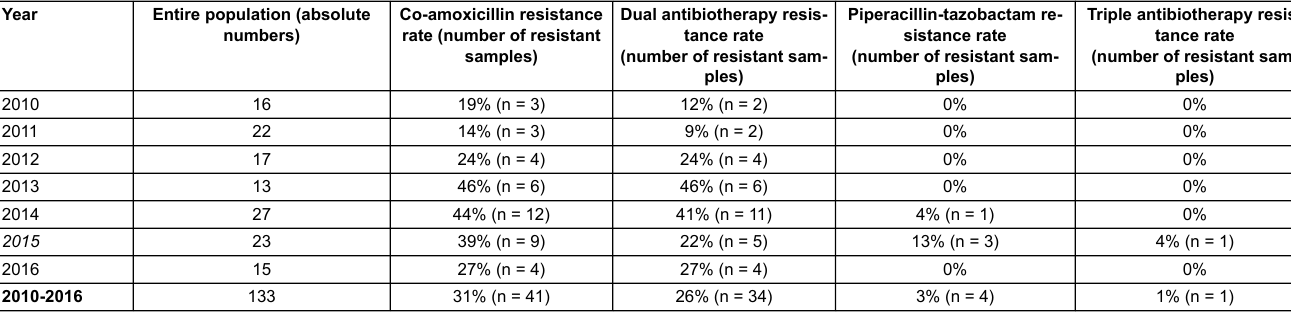
Table 2: Antimicrobial resistant rates of peritoneal samples over time.